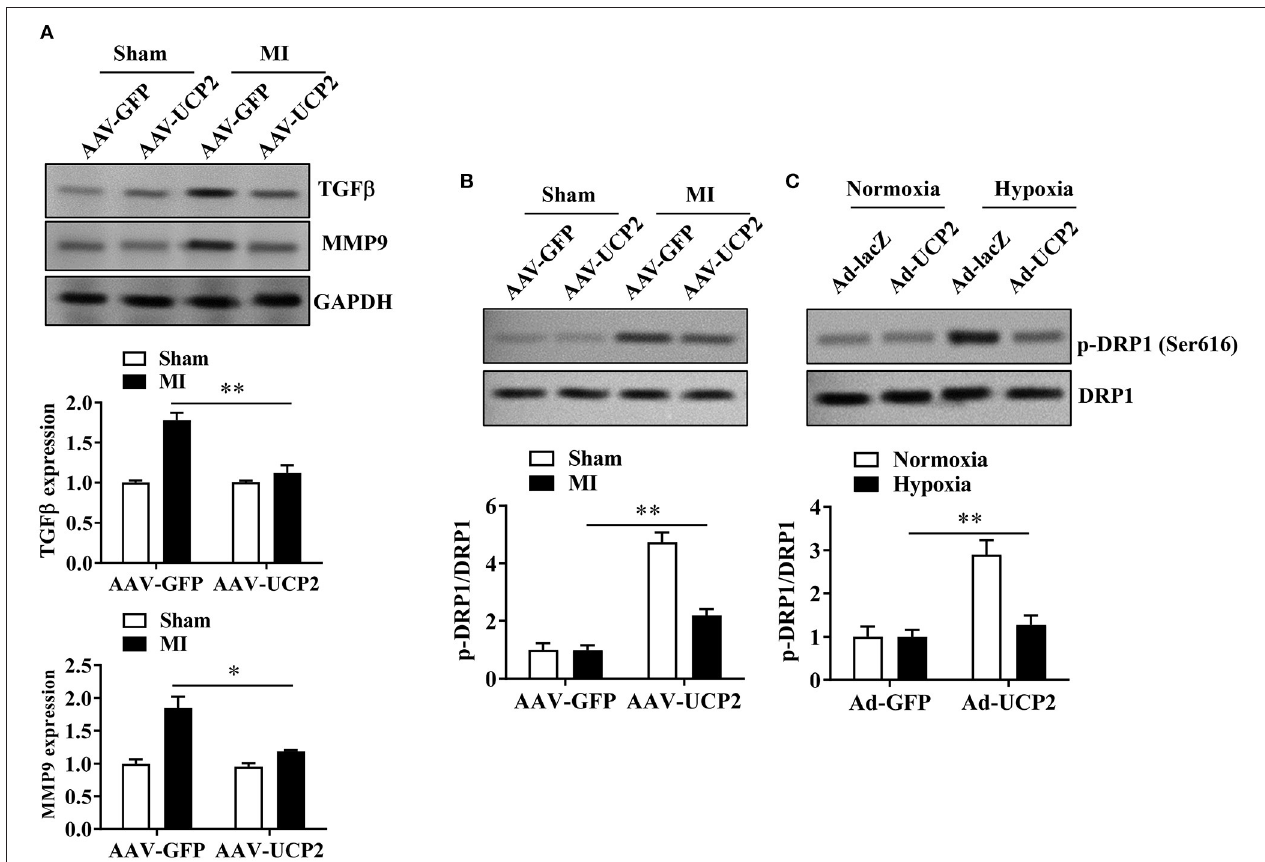
FIGURE 5 | The effect of UCP2 overexpression on fibrosis-related proteins and DRP1 phosphorylation 4 weeks after MI. (A) UCP2 overexpression in heart reduces the expression of fibrosis-related protein MMP9 and TGF- β . (B,C) UCP2 overexpression in heart or cell increases the expression of p -DRP1/DRP1 4 weeks after MI. MI, myocardial infarction;* p < 0.05, ** P < 0.01 compared with each